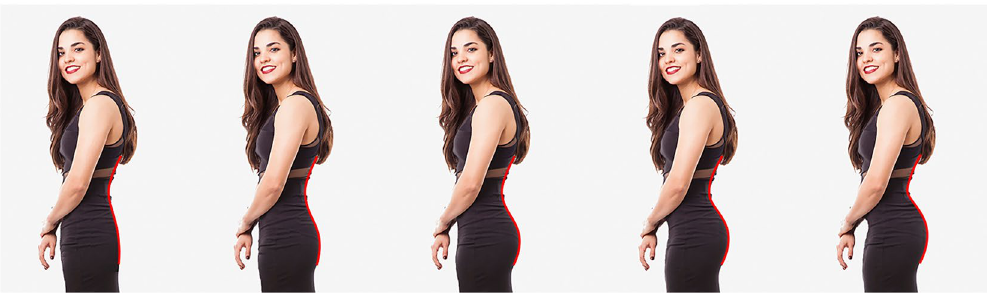
Figure 3. Photorealistic stimuli (morphs) depicting female characters varying in lumbar curvature. The red lines (not shown to participants in Study 1) represent the corresponding body lines used in Study 2. The photorealistic stimuli were reproduced with permission from Lewis et al. 16